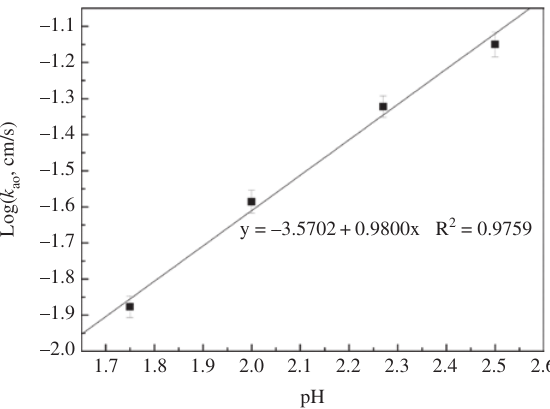
Figure 5: Effect of pH value in the aqueous phase on extraction rate. stirring speed = 250 rpm, T = 298